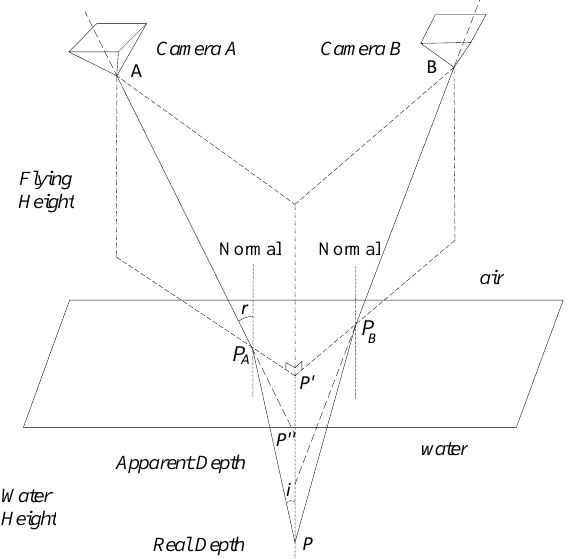
Figure 1. The geometry of two-media Photogrammetry (Fryer and Kniest,